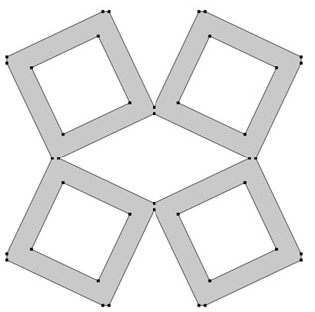
Figure 7. The obtained unit cell for w 1 = 0.45. The last analyzed parameter was the radius of the fillet in the middle part of a unit cell. The parameter has a value from 0 to 0.15 (Figures 8–10).